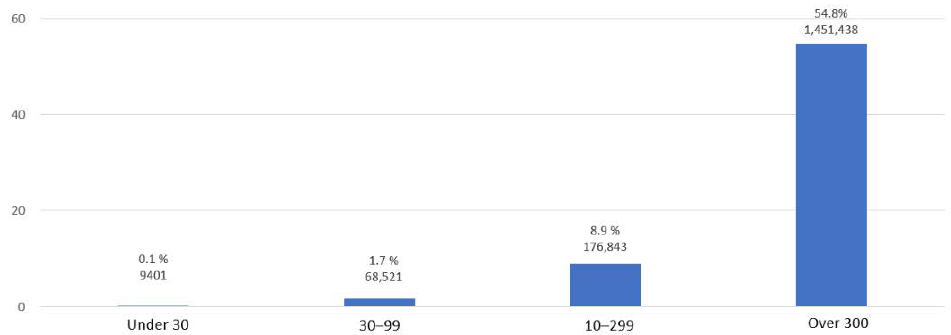
Figure 15. Trade union organization rate and number of members by firm size (2019). Source: Ministry of Employment and Labor [65].